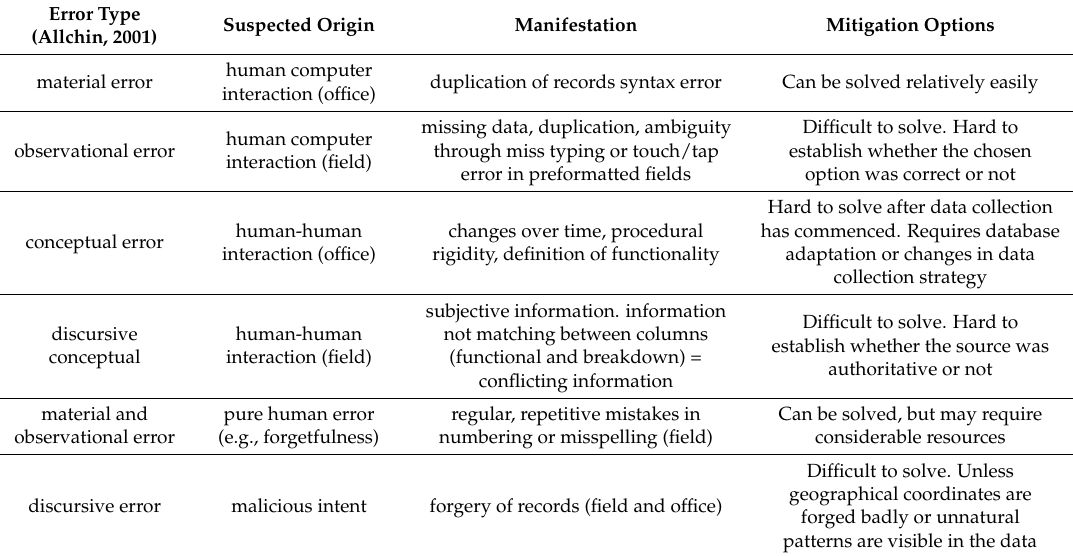
Table 1. Broadly suspected causes of error in Water Point Mapping data categorized according to error typology adapted from Allchin